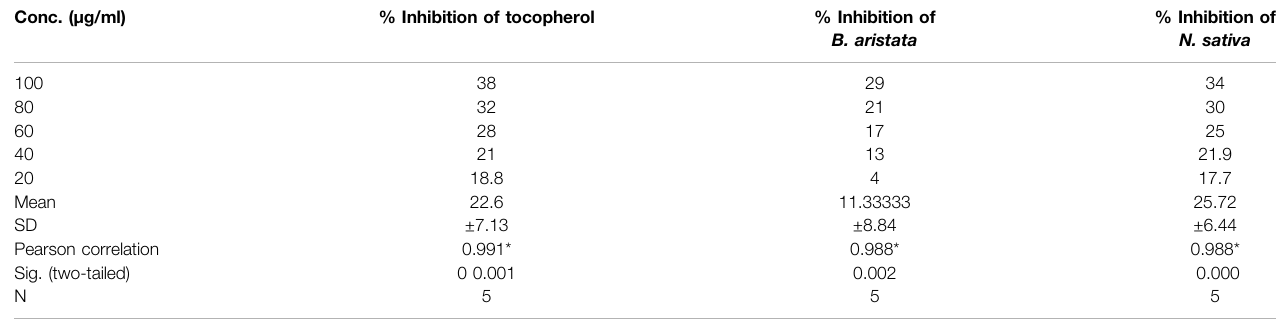
TABLE 2 | Absorbance versus concentrations of α -tocopherol, B. aristata , and N. sativa . Conc. (µg/ml) % Inhibition of tocopherol